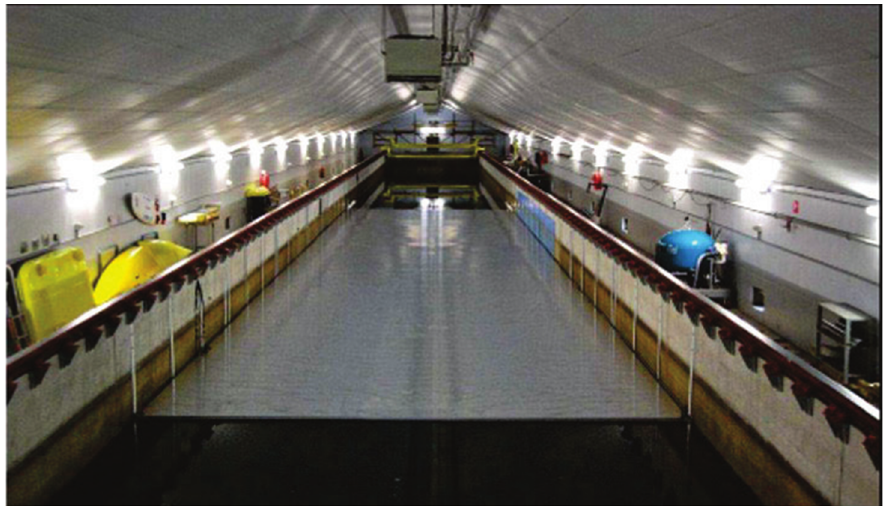
Figure 6. Towing tank for the experiments in this paper. Table 4. Comparison of resistance between simulation and